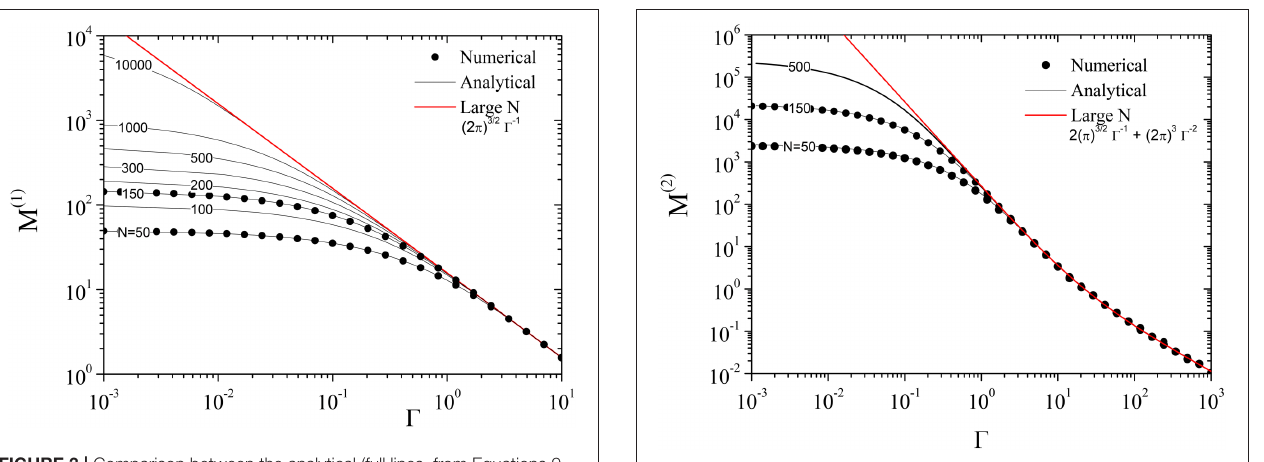
FIGURE 4 | Comparison between the analytical (full lines, from Equations 11, 55, and 56) and numerical (black dots) results for the second moment M (2) of the spectral density of states ρ ( λ ). The data at the indicated selected N values are reported as a function of the parameter Ŵ . The N values ( N = 50, 150, and 500 for the analytical case and 50 and 150 for the numerical one) are indicated on the black curves. The red line is the asymptotic, N Equation (58).